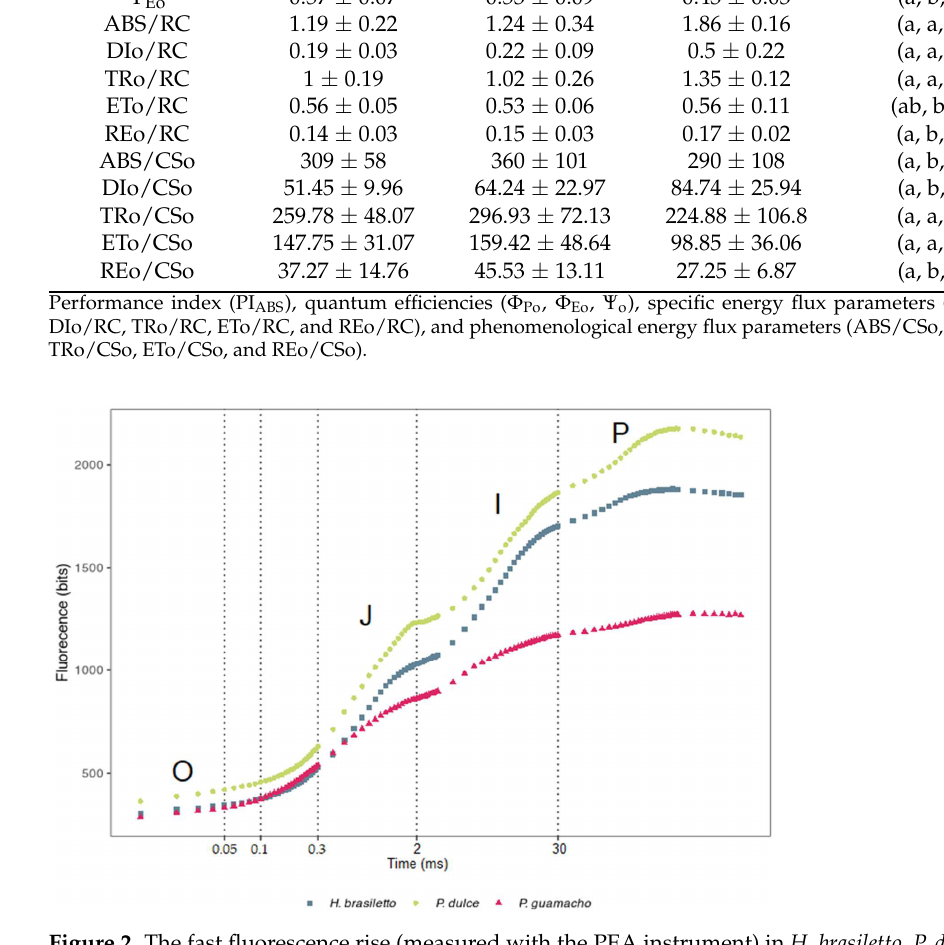
Figure 2. The fast fluorescence rise (measured with the PEA instrument) in H. brasiletto, P. dulce , and P. guamacho leaves. Transient curves of each line represent the average of 7 plants.